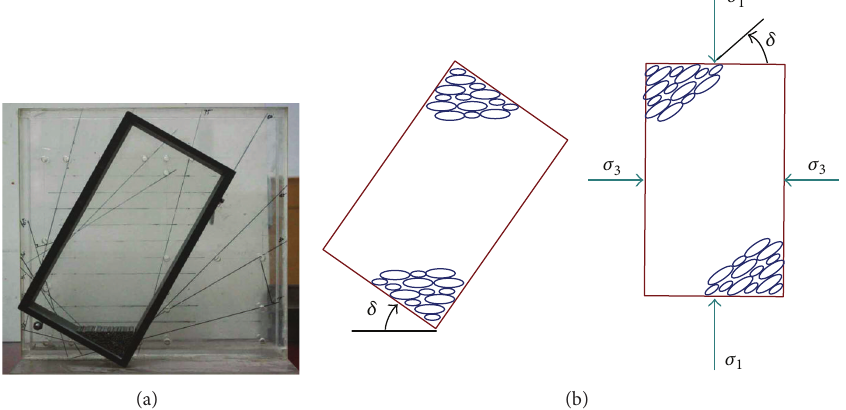
Figure 2: Specimen fabrication method for the tilting angle of 𝛿 : (a) fix the rectangular frame according to the required tilting angle of 𝛿 ; horizontally place the mixed rods into the frame layer by layer, (b) remove the rectangular frame when it was filled with rods, and rotate back to the horizontal direction.